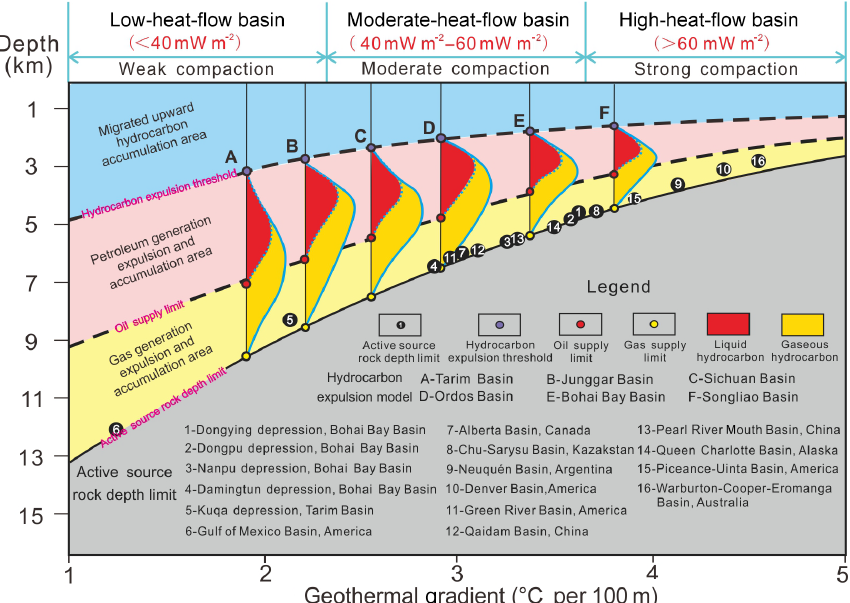
Figure 10. The pattern of ASDLs on the formation and distribution of hydrocarbon reservoirs in petroliferous basins. The upper blue area is favorable for the formation and distribution of conventional oil and gas resources, and hydrocarbons come from the underlying source rocks. The middle pink area is favorable for oil and gas generation, migration, and accumulation from source rocks in this area, mainly from conventional oil and gas reservoirs. The lower yellow area is favorable for natural gas generation, migration, and accumulation from source rocks, mainly from tight unconventional gas